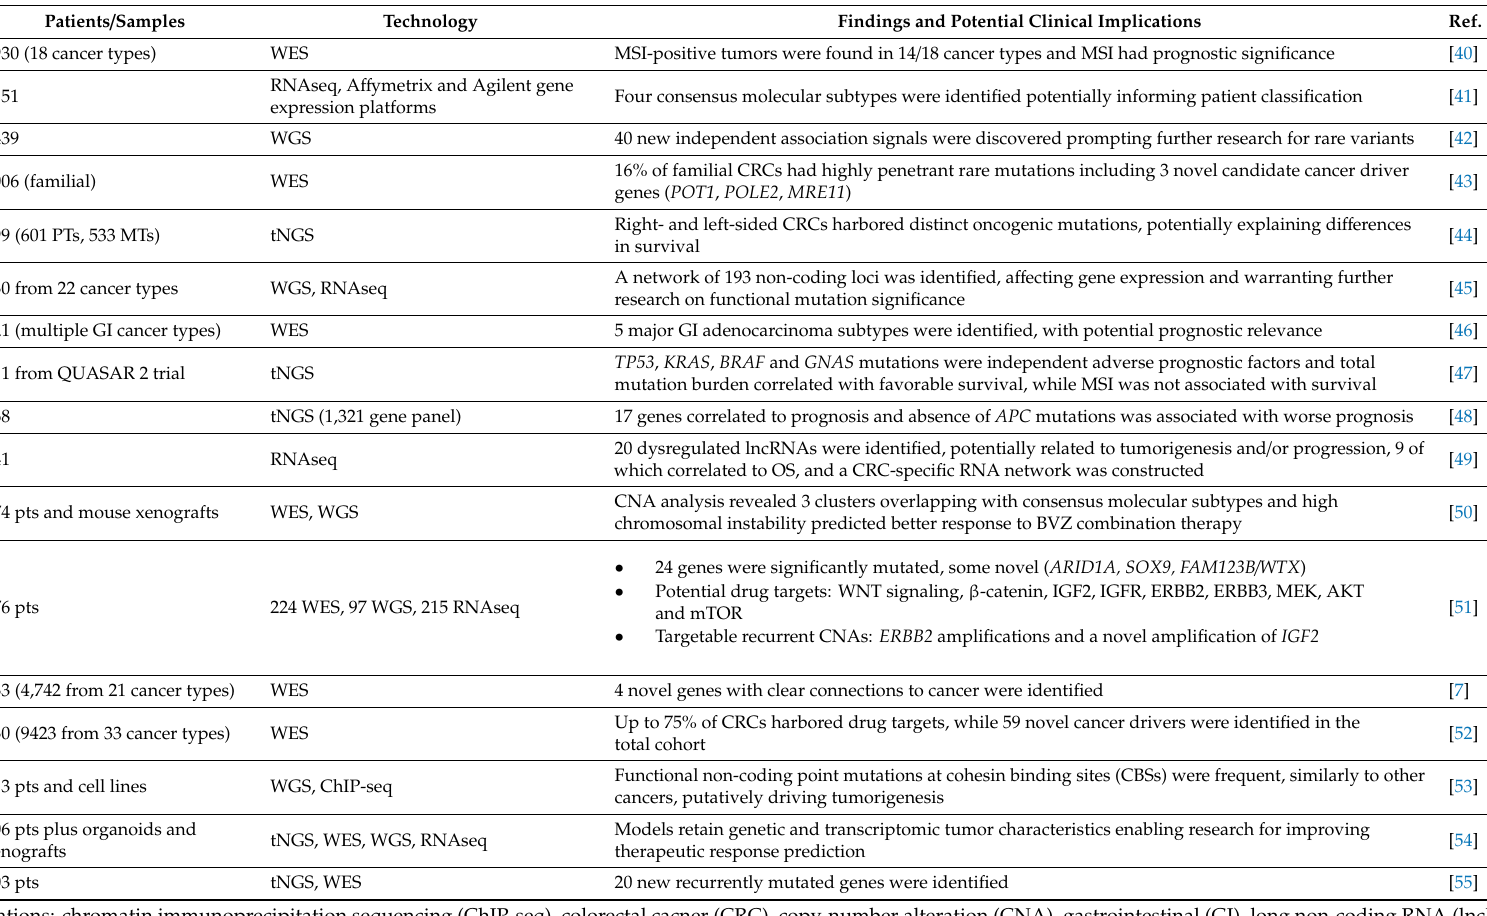
Table 1. Exploration of inter-patient genomic and transcriptional